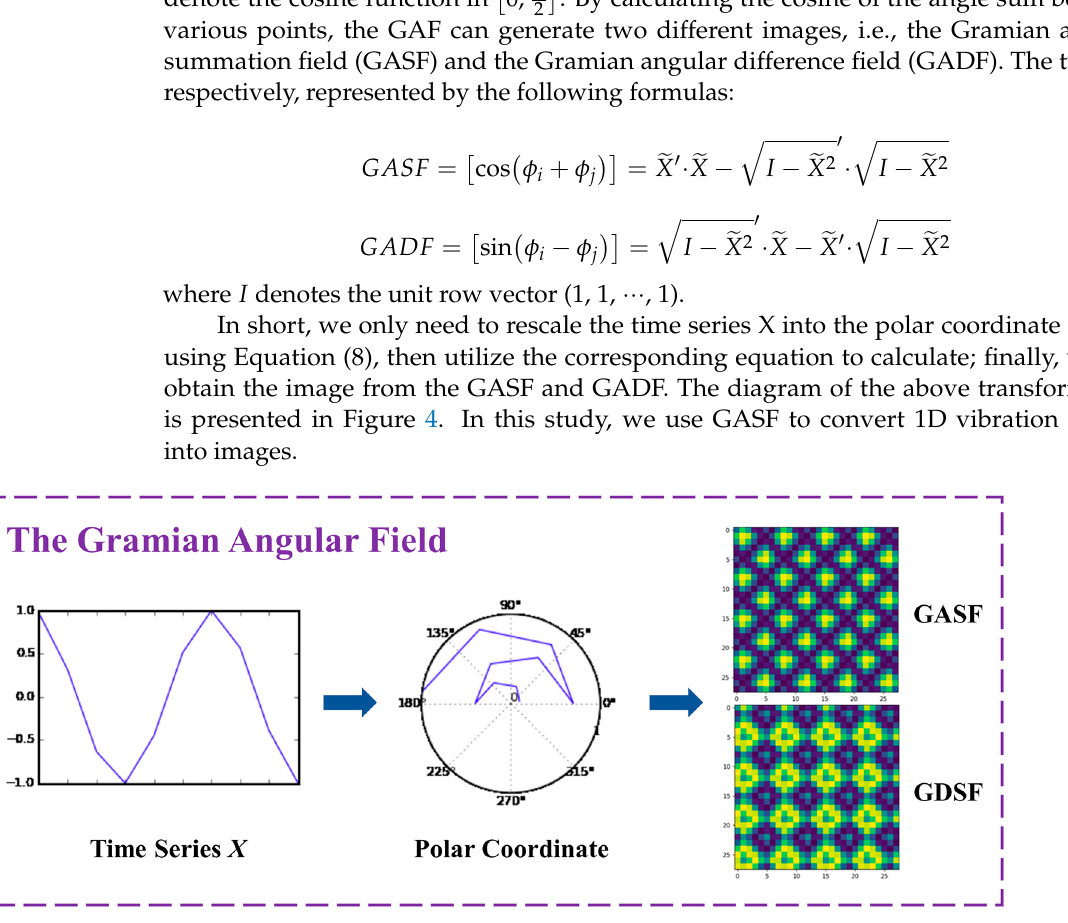
Figure 4. Diagram of the GAF conversion